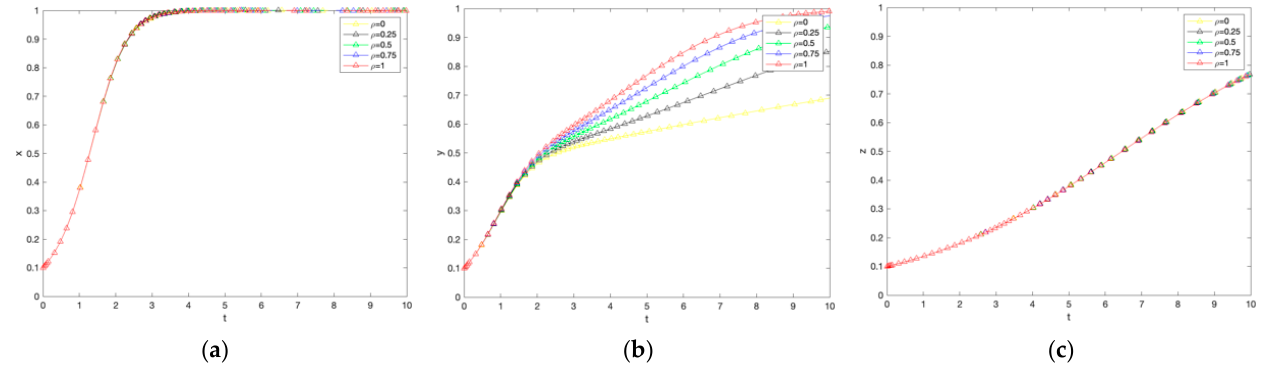
Figure 7. The impact of changes in the influence coefficient of the willingness to pay premiums for carbon-labelled agricultural products on government subsidies, farmer adoption, and consumer purchases. ( a ) Government response. ( b ) Farmers’ response. ( c ) Consumer reaction.